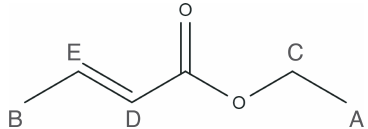
Figure 1. Molecular structure of ethyl crotonate and proton labels used throughout this